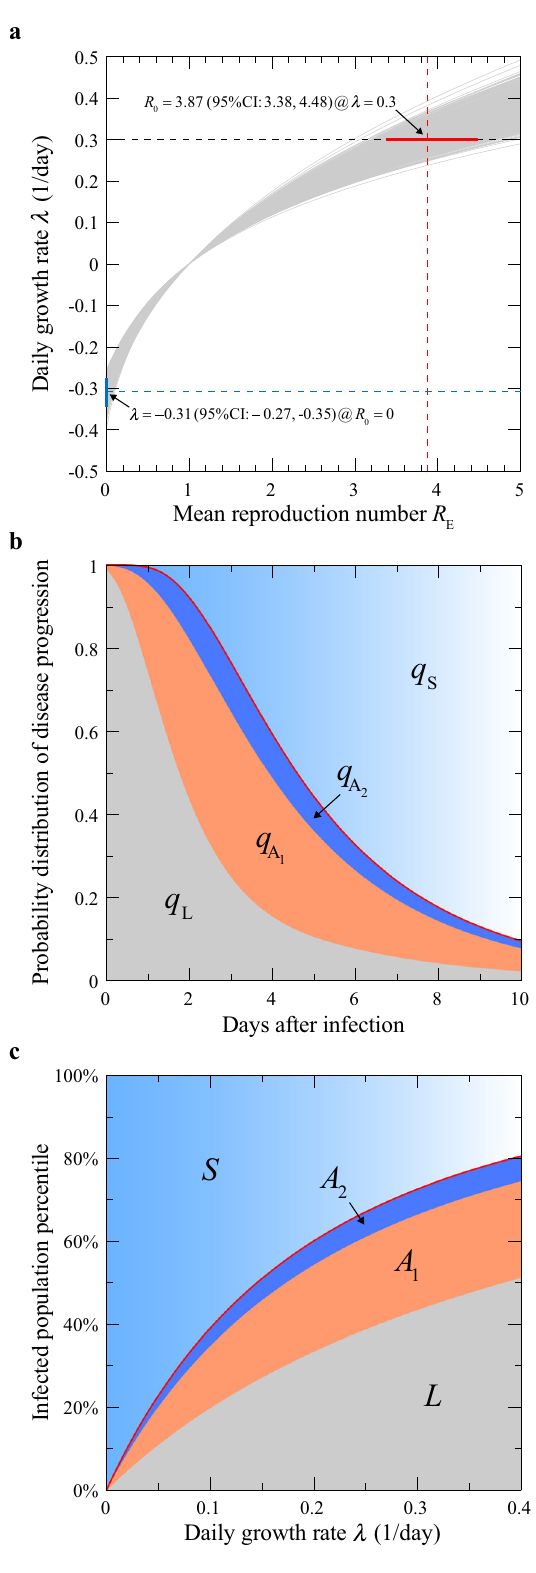
testing outcomes with one day delay (red curve). The largest reduction is obtained when the test is performed 3 days after the contact. This corresponds to the day when the width of the orange plus dark blue region in Fig. 3b is the widest. For contact tracing and quarantine, we show our results under the scenario that a fraction q c of infectees are tracked down and